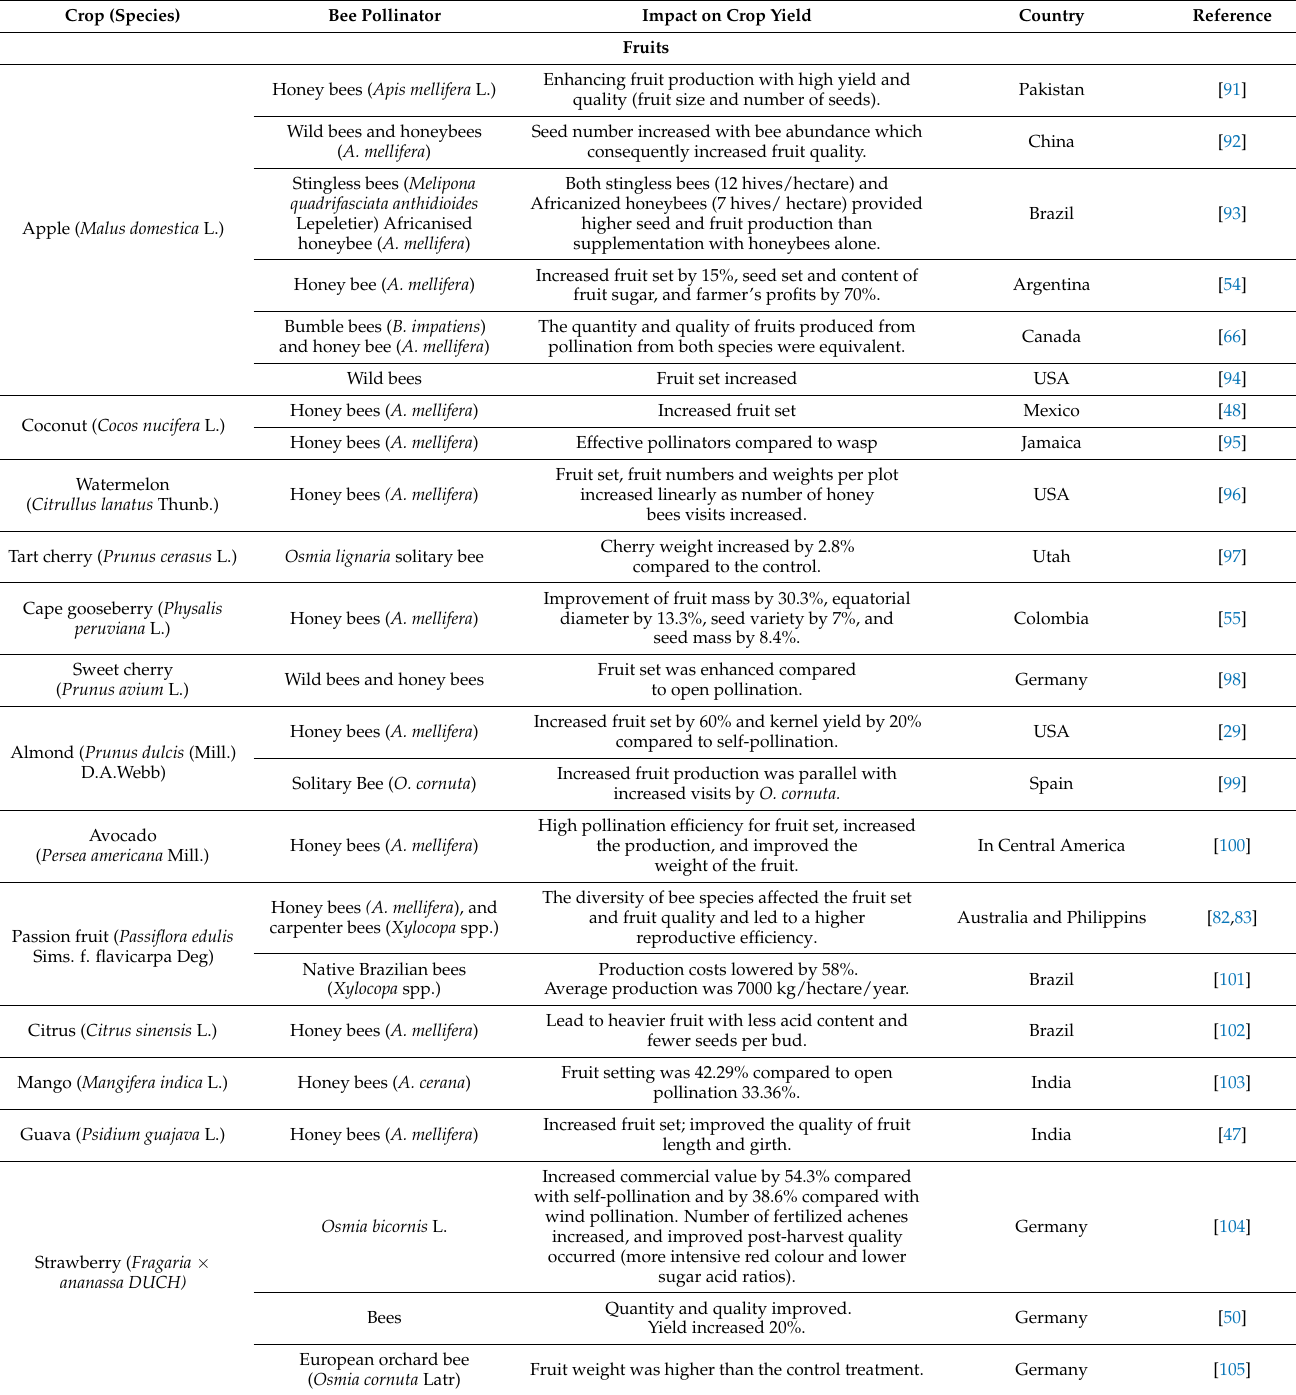
Table 1. The impact of bee pollination on crop quality and productivity in various